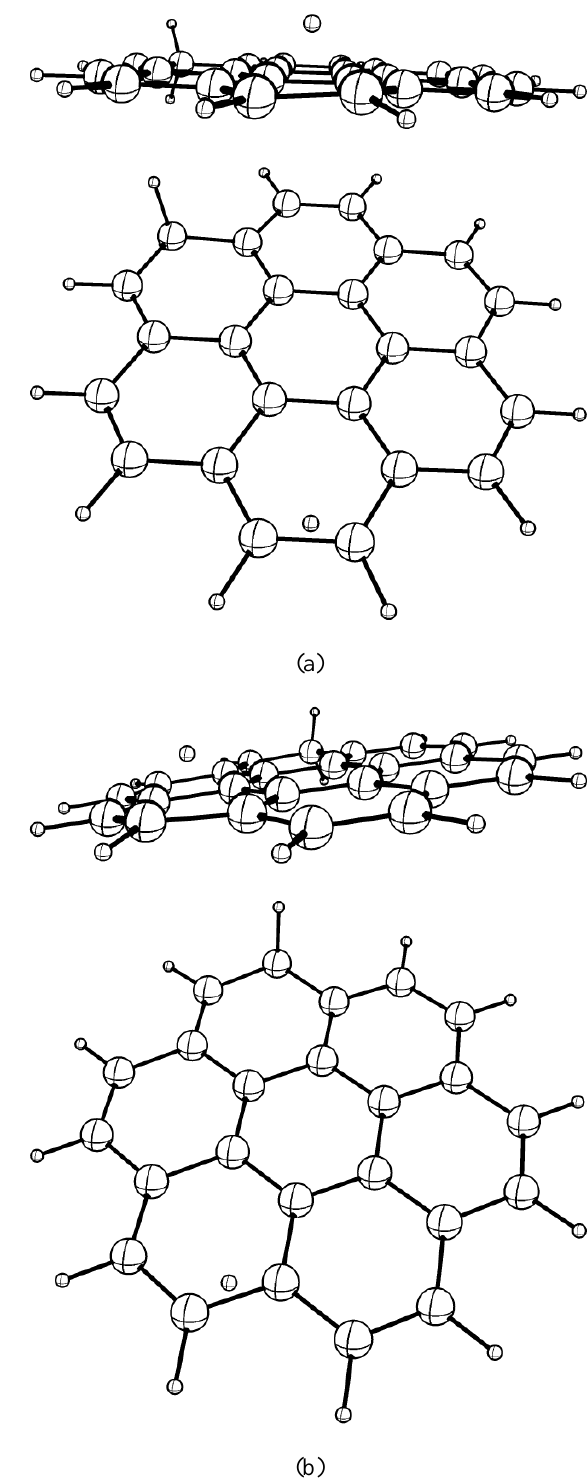
Fig. 4. The transition state of edge migration, a and b for non radicals (side and top